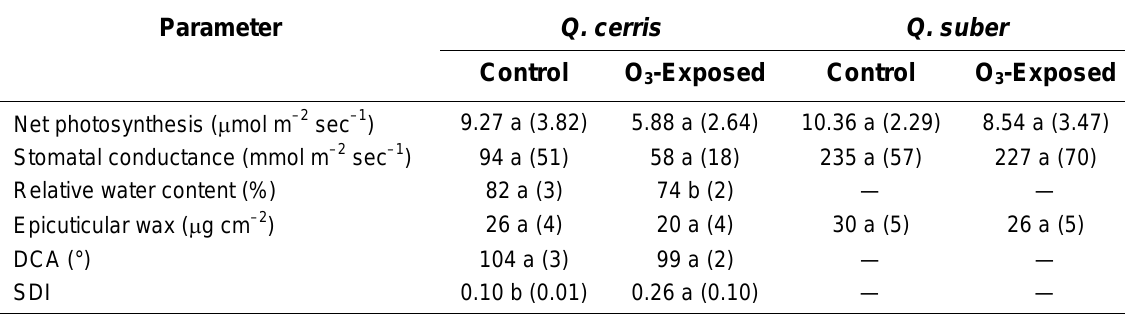
-Exposed (110 ppb O 3